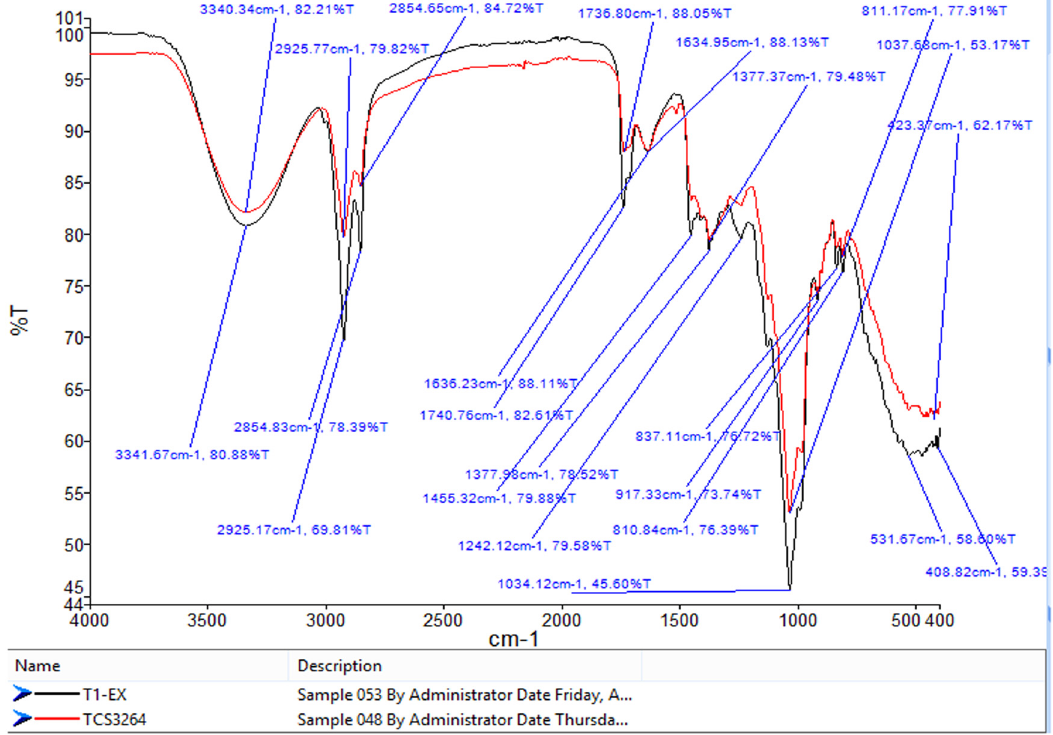
Figure 13: Comparative FTIR spectra of T. govanianum crude methanol extract and silver